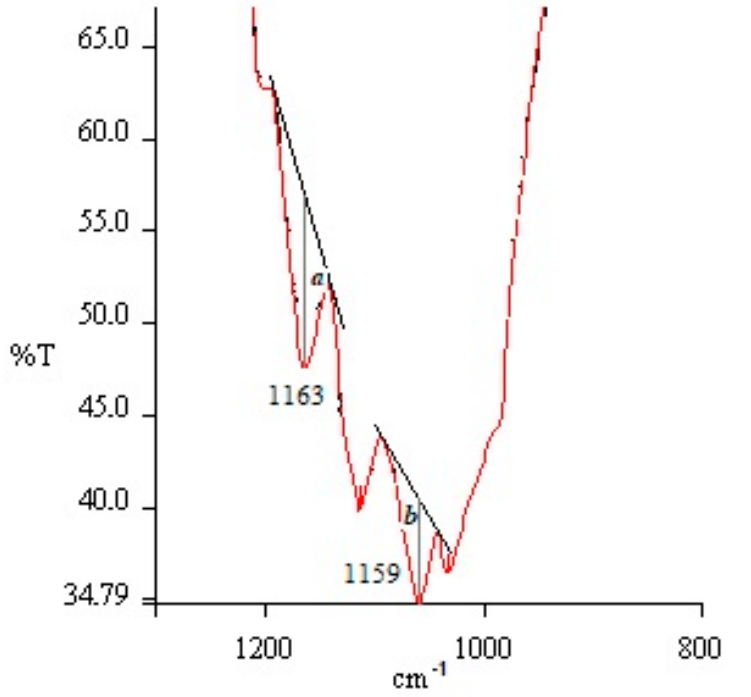
Figure 3. Calculation method for crystallinity index in relation to changes in absorption peaks 1163/1159 cm − 1 in the infrared absorption